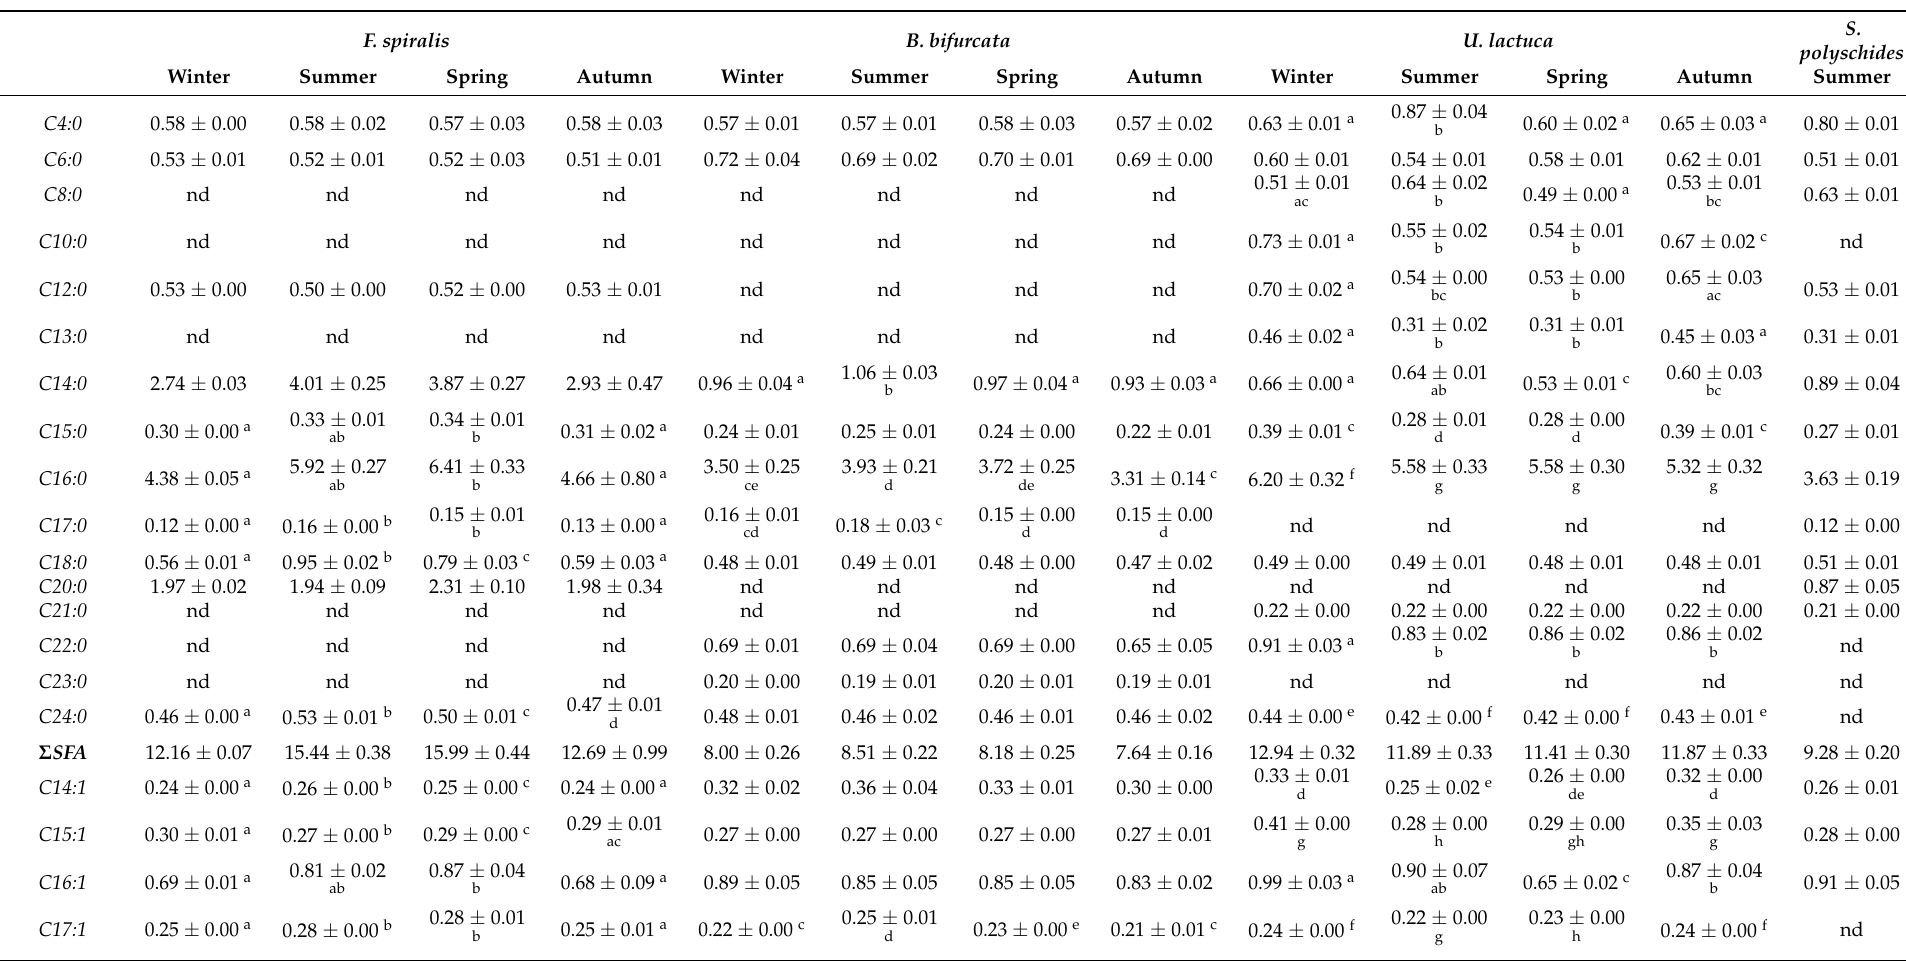
Table 1. Seasonal mean fatty acids composition of Fucus spiralis , Bifurcaria bifurcata , Ulva lactuca, and Saccorhiza polyschides , presented as µ g of fatty acid/mg of macroalgae. For Saccorhiza polyschides only summer data are presented, due to lack of samples from the other